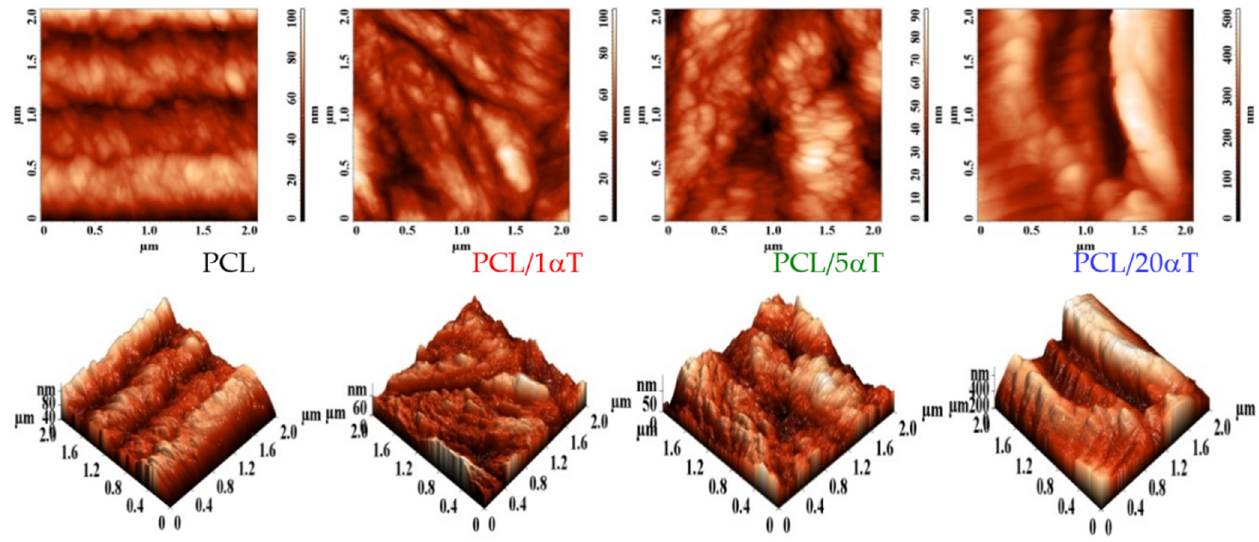
Figure 6. 2D and 3D AFM images at 2 × 2 µ m 2 scan area of electrospun fibers of PCL with different α -tocopherol concen-